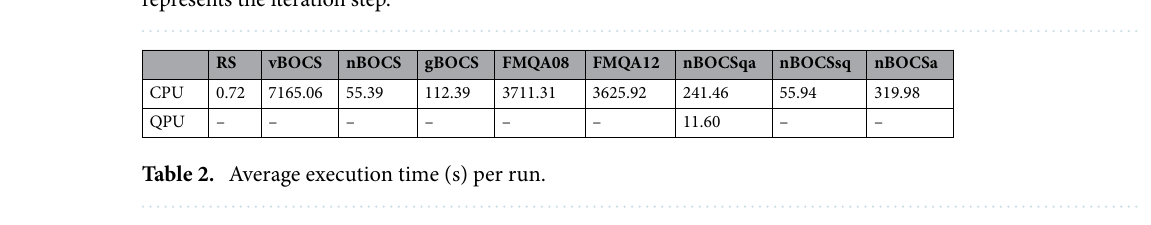
Figure 4. The population of the four domains for five individual runs for various algorithms. The x-axis represents the iteration step.